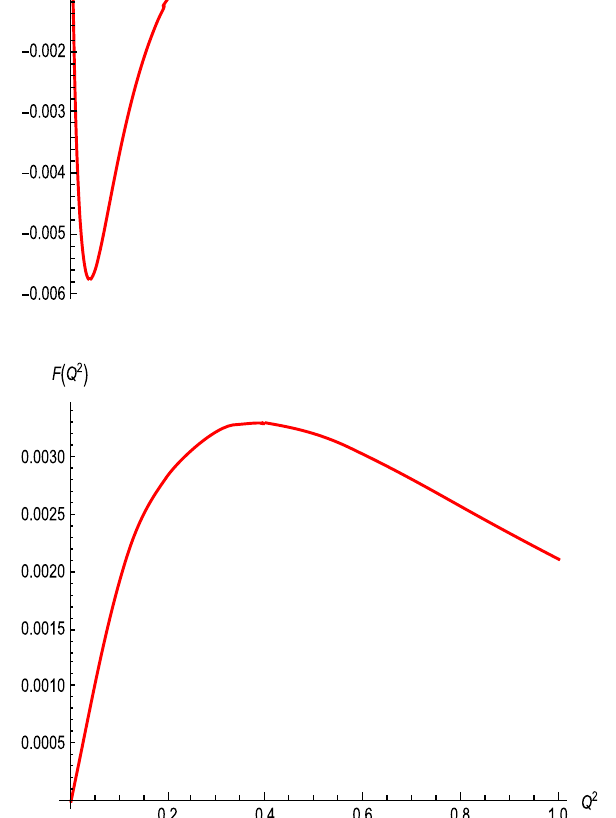
Fig. 19 Same as in Fig. 18 between 3 → 4: No. 3( n = 1 ,κ = 2, abnormal) and No. 4 ( n = 2 ,κ = 2, abnormal) (upper panel); 2 → 3: the state No. 2 ( n = 2 ,κ = 0, normal) and the No. 3 ( n = 1 ,κ = 2, abnormal) (central panel) and 2 → 4: the state No. 2 ( n = 2 ,κ = 0, normal) and No. 4 ( n = 2 ,κ = 2, abnormal) (lower panel)